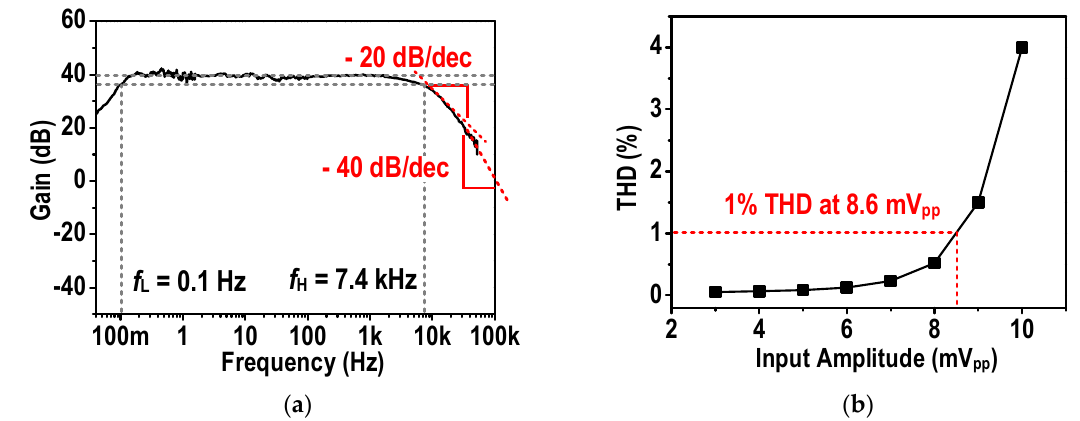
Figure 12. LNA characteristics: ( a ) Measured frequency response of the LNA from 50 mHz to 50 kHz; ( b ) total harmonic distortion (THD) with a 1 kHz sinewave.